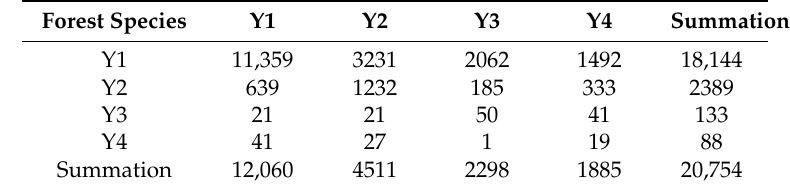
Figure 4. Spatial distribution of dominant function evaluation of forest resources in Rongshui County, Guangxi Zhuang Autonomous Region. Table 6. Classification confusion matrix of dominant function. Y1, Y2, Y3, and Y4 are the scores of wood production function, water conservation function, water and soil conservation function, and other functions, respectively. The row in the figure represents the subcompartment planning forest species, and the dominant function evaluation of the subcompartment that was shown in the list.